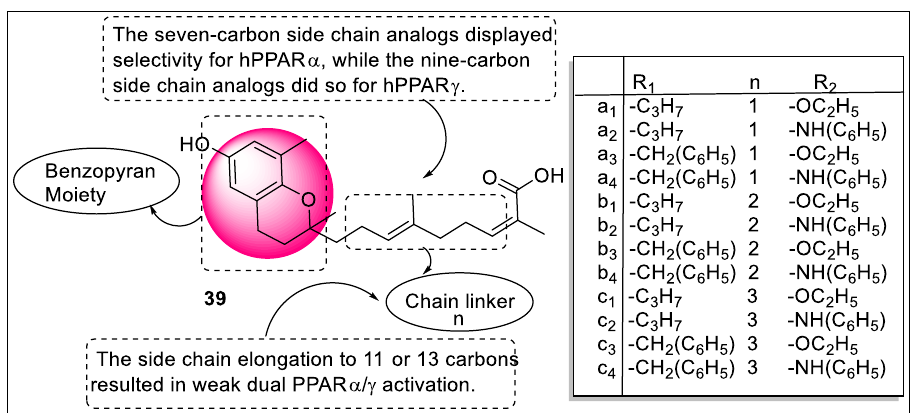
Figure 43. Structural activity relationship of benzopyran hybrids ( 39 ) as potent PPAR ligands.